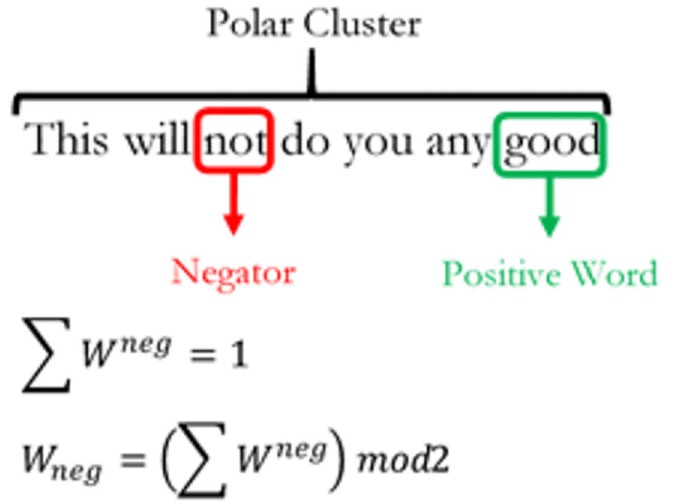
Fig 2. The net negation effect on the polarized word in a sentence